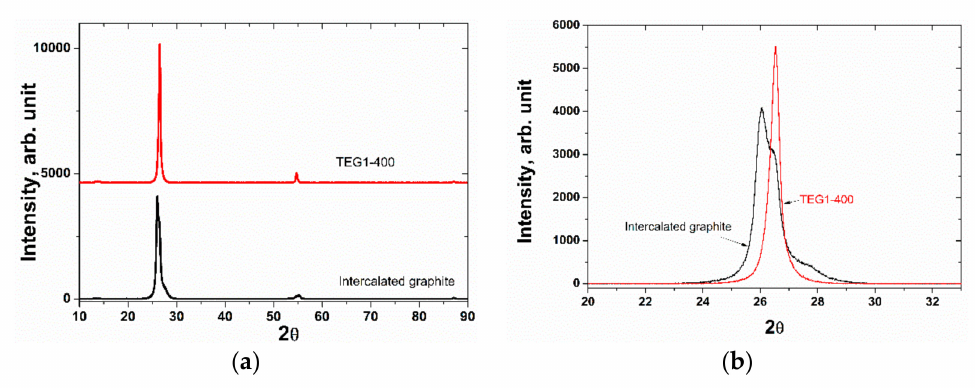
Figure 6. XRD patterns of the intercalated graphite and TEG1-400 ( a ) and 002 reflection of these samples ( b